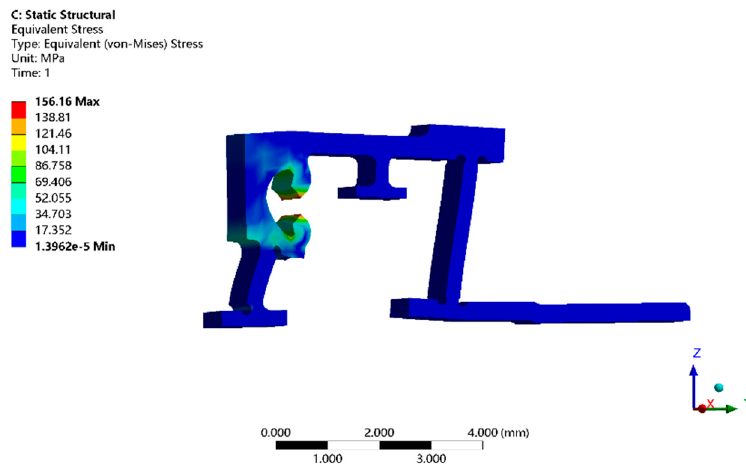
Figure 10. Flexible hinge stress simulation results.